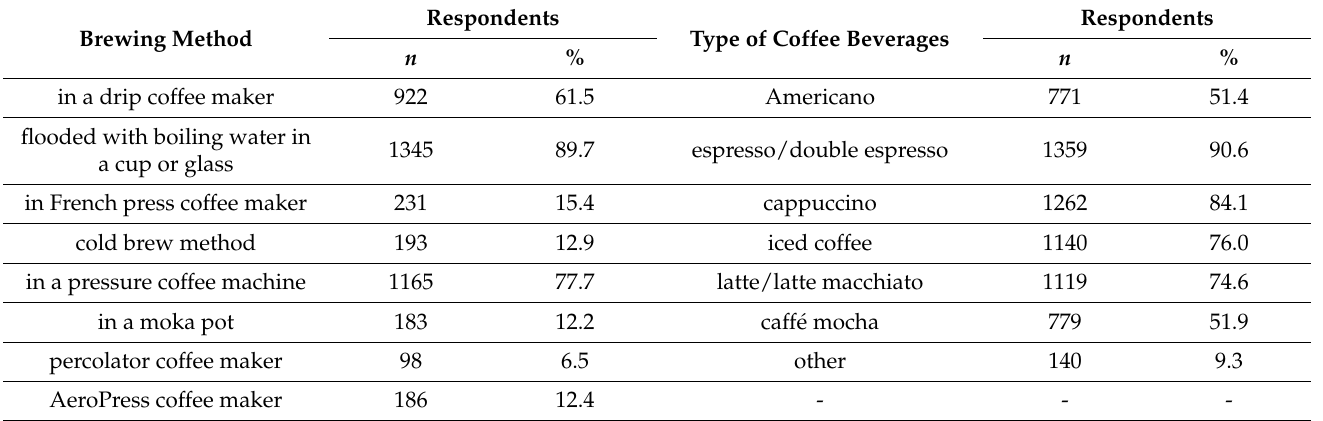
Table 5. Preparation methods and types of coffee beverages by